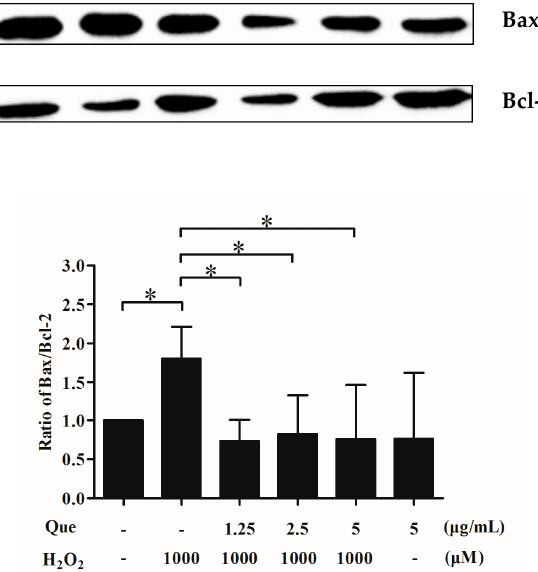
Figure 7. Effects of Que on Bax/Bcl-2 of IPEC-J2 exposure to H 2 O 2 . ( a ) Bands of Bax and Bcl-2 of IPEC-J2 by western blot; ( b ) Histogram of Bax/Bcl-2 of IPEC-J2. Data are presented as mean ± SD. * p < 0.05 means significant difference between two groups.